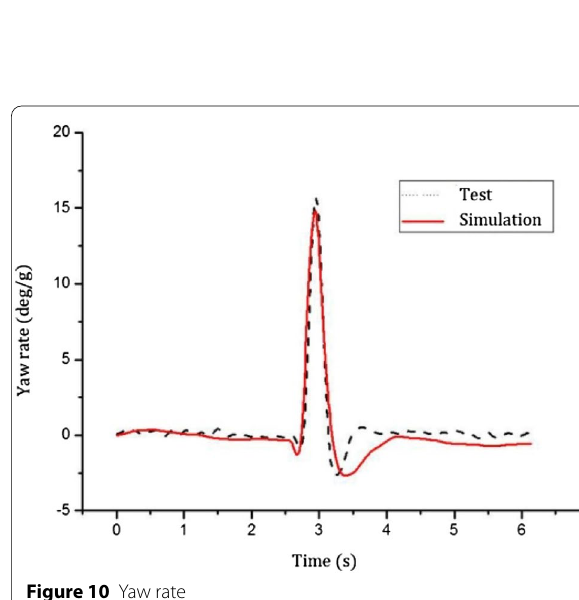
Figure 9 Lateral acceleration